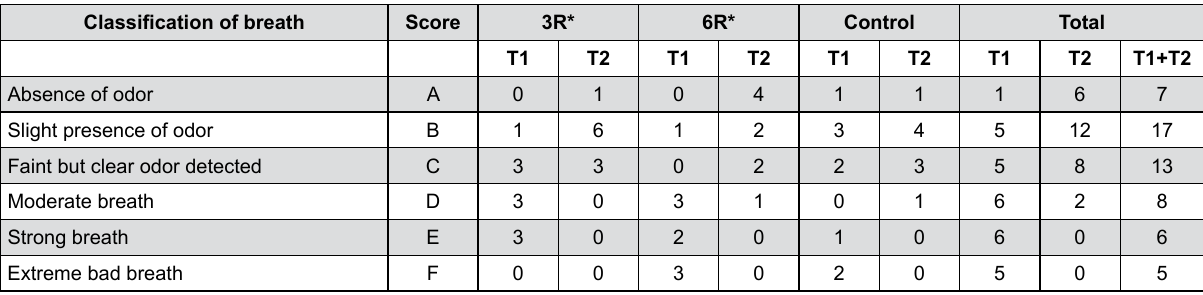
Figure 2- Organoleptic assessment scores for the three groups at the two consultations (T1: initial consolation; T2: two-week follow-up consultation). Results of the subjects’ organoleptic exams at the two consultations: T1 (initial examination) and T2 (two-week follow-up examination) in the three experimental groups: the 3R group, the 6R group, and the control group. The Wilcoxon signed-rank test revealed a statistically significant difference between T1 and T2 in the 3R group (p=0.011) and in the 6R group (p=0.007). The control group exhibited no differences between the two exams (p=0.071). The Kruskal-Wallis test revealed no statistically significant differences between the two test groups (p=0.531), a finding which was confirmed by ANOVA (p=0.577). The Wilcoxon single-ranked test. *Statistically significant difference; Table 1- Visual analog scale (VAS) test presented by the mean of each of the three groups (3R, 6R, and control) at both consultations (T1: initial examination and T2: two-week follow-up examination)